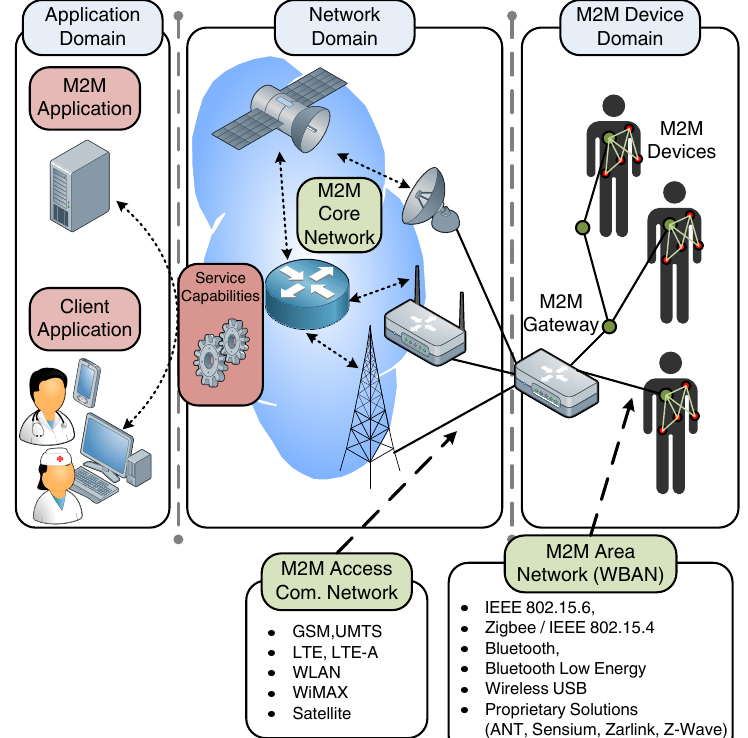
Figure 1. Simplified Machine-to-Machine (M2M) architecture for wireless connectivity in mHealth